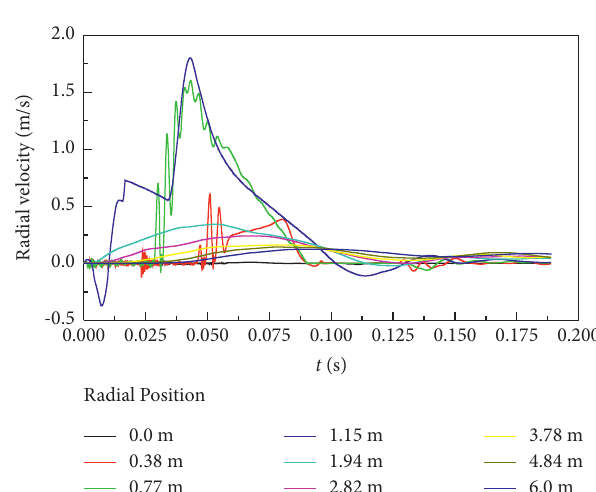
Figure 13: Radial velocity of surface particles.